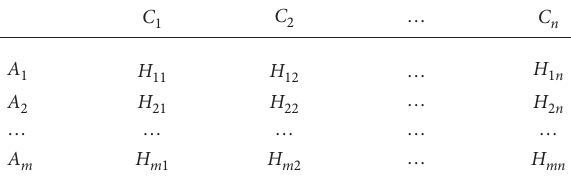
Figure 1: Decision